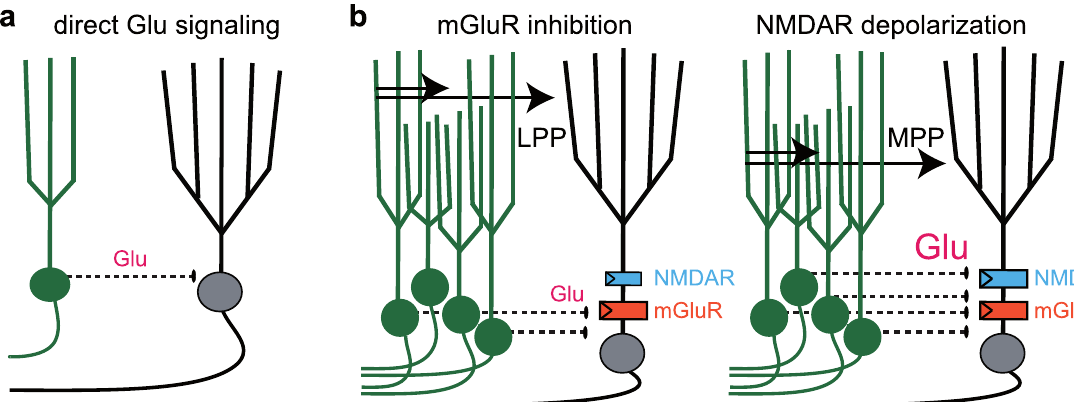
Figure 3. Controlling mature granule cell excitability by glutamate-mediated excitation and inhibition. a . Depiction of young granule cells (GCs) (green) releasing glutamate (Glu) directly onto mature GCs (black). b . Summary of the proposed circuit mechanism from Luna et al. 66 , whereby direct glutamatergic signaling allows pathway-specific modulation of mature GC excitability. Left: stimulation of the lateral perforant path (LPP) recruits a small number of young GCs, leading to low Glu levels sufficient to activate extrasynaptic metabotropic Glu receptors (mGluRs) (orange) that hyperpolarize mature GCs. Right: stimulation of the medial perforant path (MPP) recruits a larger number of young GCs, releasing more Glu that also activates extrasynaptic N-methyl-D-aspartate receptors (NMDARs) (blue) that depolarize mature